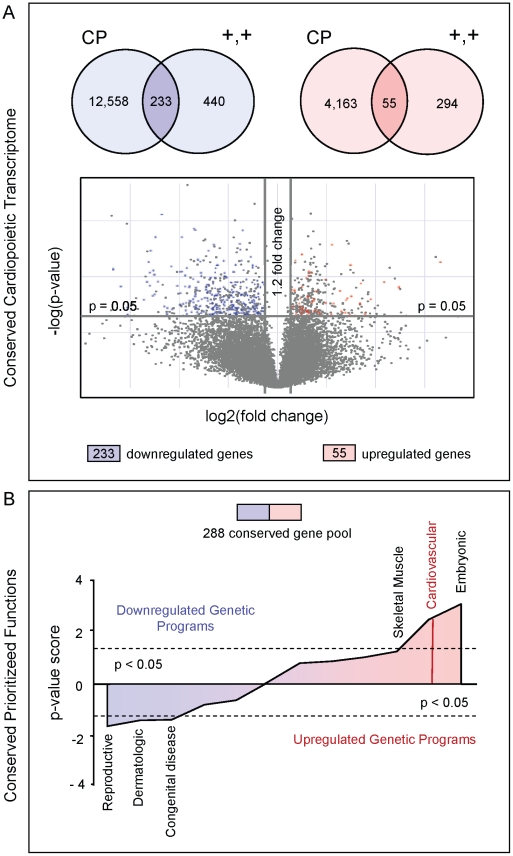
Transcriptome intersection of cardiopoietic and double positive progenitors uncovers a conserved cardiac signature.(A) Upper – Venn diagrams revealed a common transcriptome pool of 55 up-regulated and 233 down-regulated genes that represented similarly changing genes in cardiopoietic (CP) and double positive (+,+) cells. Lower – Volcano plot analysis of the double positive progenitor cell transcriptome (grey), overlaid with up-regulated (red dots) and down-regulated (blue dots) transcripts shared with CP. (B) In silico gene ontology analysis of the common progenitor transcriptome revealed persistent functional prioritization of “Cardiovascular Development”. Developmental categories are plotted according to a p-value score calculated to represent a weighted ontologic functional prioritization within the integrated 288 gene pool, i.e., p-value score  =  -log(p-value-Upregulated List) - (-log(p-value-Downregulated List). Red (positive y-axis) designates overall upregulated developmental programs within the integrated transcriptome, while blue (negative y-axis) designates overall downregulated developmental programs.